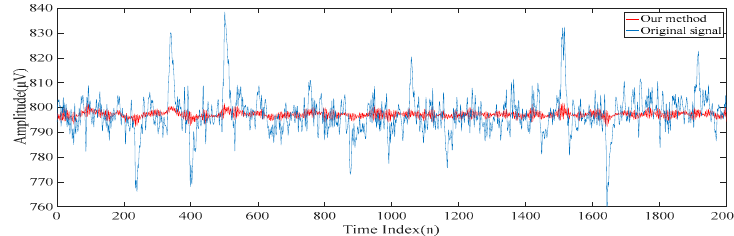
Figure 8. ( a ) The low-rank component after performing the low-rank decomposition on the residue of the electroencephalogram. ( b ) The sparse component after performing the low-rank decomposition on the residue of the electroencephalogram.